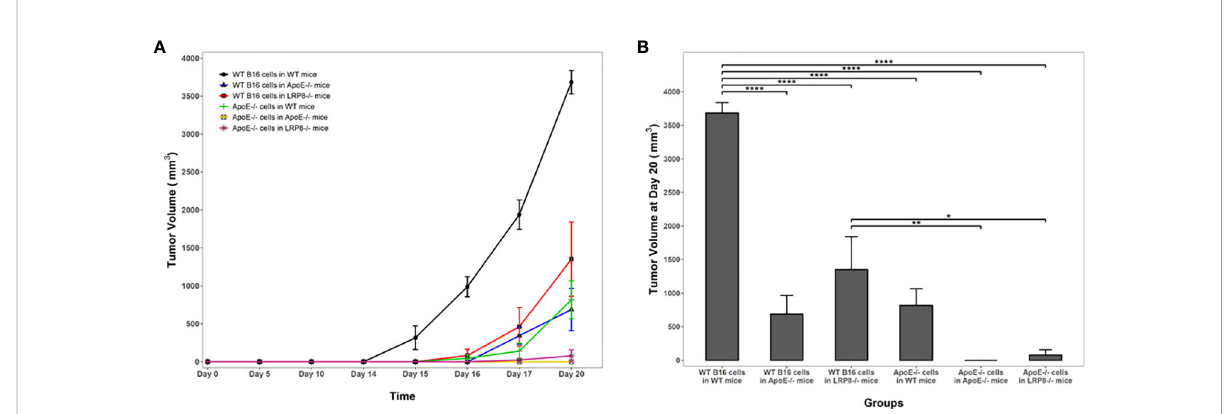
FIGURE 5 Knock out of apoE in both B16 tumor cells and in mice enhances host immunity and attenuates tumorigenicity. (A) In vivo, 104 WT or apoE-/- B16 cells were injected into the right leg of WT (n=9), apoE-/- (n=9) or lrp8-/- mice (n=9). The average tumor growth in each group (n=6) is compared. Tumor growth was signi fi cantly slower when apoE-/- B16 cells were injected into apoE-/- or lrp8-/- mice versus the other groups (two-way ANOVA; P <0.0001). (B) The fi nal tumor volume between treatment groups at the end point of the experiment (Day 20) was also compared using a one-way ANOVA followed by Tukey HSD pairwise multiple comparisons between treatment groups. Tumor volumes at the end point of the experiment were signi fi cantly different between treatment groups (one-way ANOVA; P <0.0001). *p<0.05; **p<0.01; ****p<0.0001.